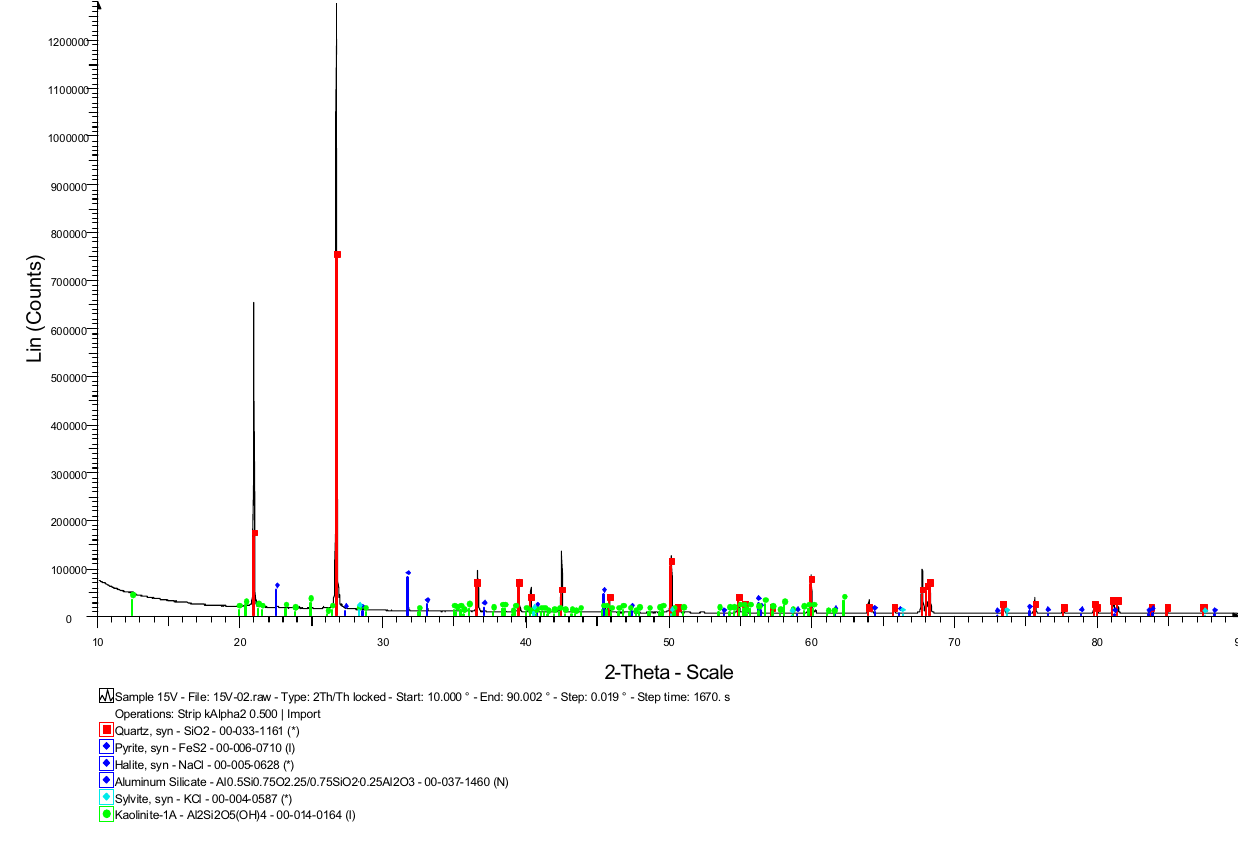
Fig. 1 XRD results showing peaks of identified